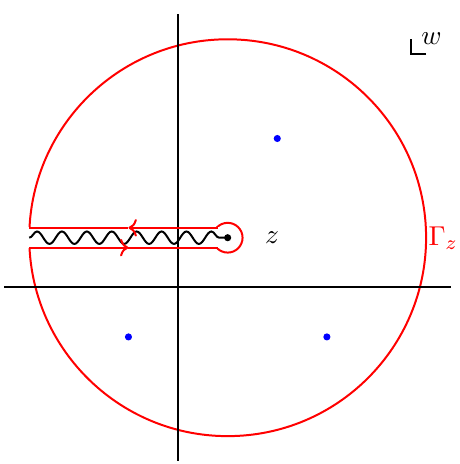
Figure 1 . Branch cut for the shadow kernel in the complexified celestial sphere coordinate w . The blue dots indicate locations of other operator insertions which from the form of the tree level celestial OPEs are known to give poles in w